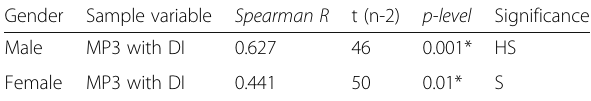
Table 4 Correlation of modified MP3 with DI Gender Sample variable Spearman R t (n-2) p-level Significance Male MP3 with DI 0.627 46 0.001* HS Female MP3 with DI 0.441 50 0.01* S *Highly Significant Spearman ’ s correlation Spearman ’ s correlation HS: Highly Significant DI Demirjian ’ s Index, MP3 middle phalanx of the third